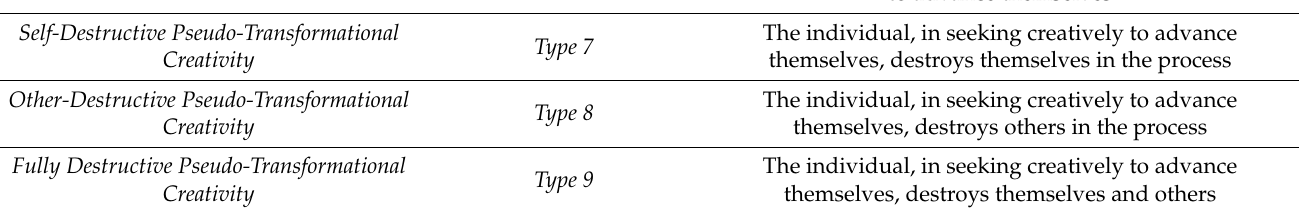
* This table is adapted and modified from Table 1 in [25]: Sternberg, R.J. (2021). Identification for utilization, not merely possession, of gifts: What matters is not gifts but rather deployment of gifts. Gifted Education International, DOI: